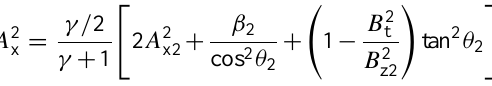
= 1 . 001, x2 / B > 0 . 1169 x x